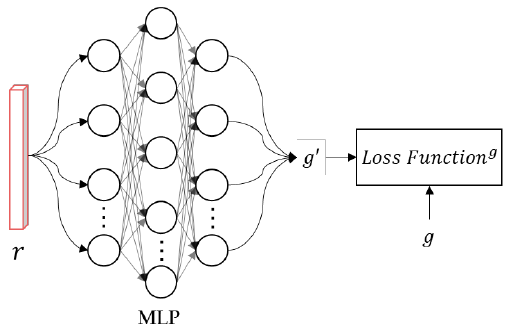
Figure 4. Structure of MLP classifier.